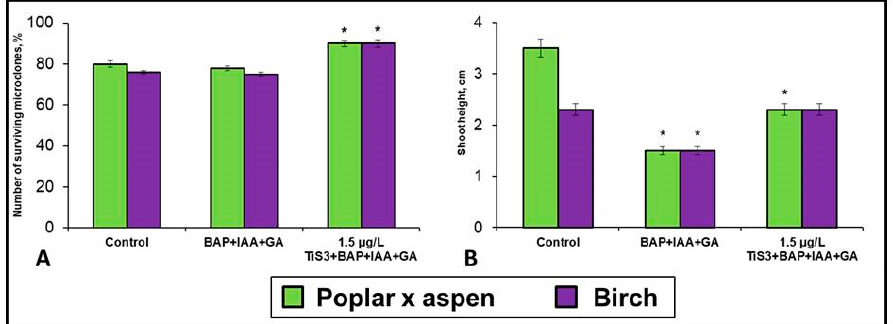
Figure 3. Biomorphological parameters of the microclones at the proliferation stage: ( A ) Mean number of the surviving microclones; ( B ) Mean shoot height.